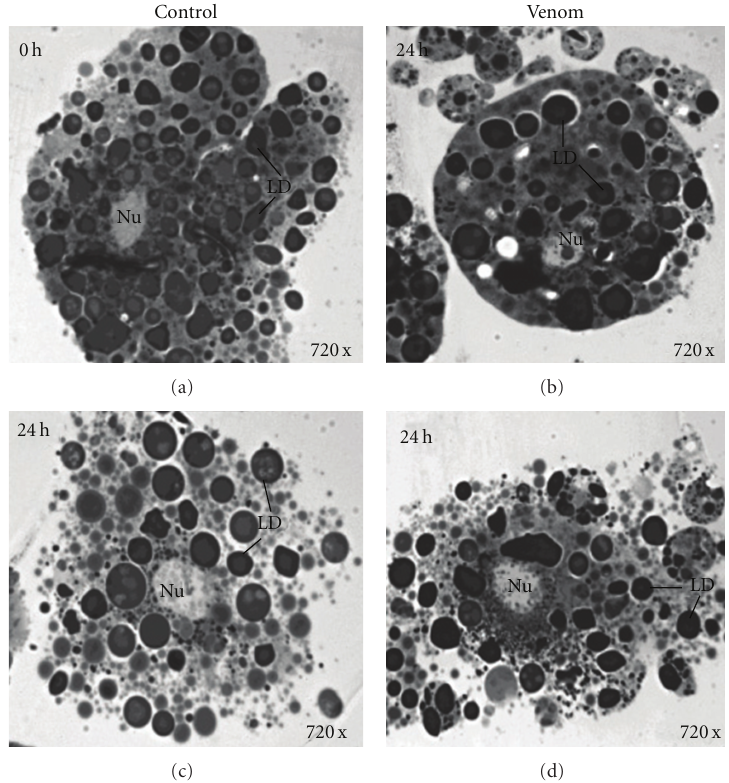
Figure 4: Light micrographs showing toluidine blue stained fat body tissue from young pharate adults of S. bullata following envenomation by N. vitripennis . Fat body examined in control and envenomated flies displayed similar cytology at 0 and 24 h posttreatment: fat body cells were large with prominent nuclei (Nu) and numerous lipid droplets (LDs) evident throughout the cytoplasm. Magnification is 720x.